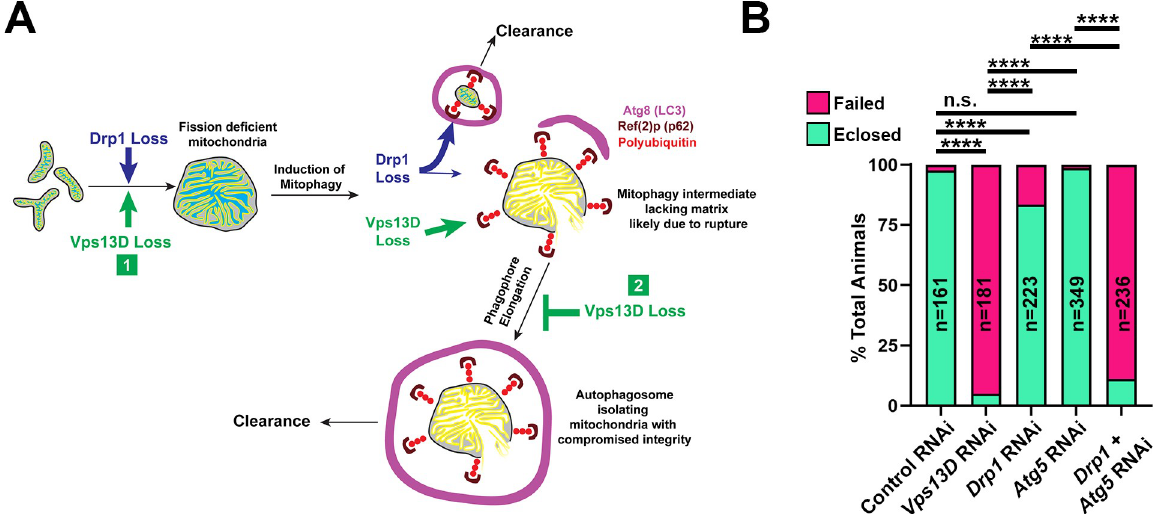
Fig 7. Two-hit model for lethality in Vps13D depleted neurons. A) Two-hit model for mitophagy intermediates lacking matrix (cyan), but containing IMM (yellow) that are present in Vps13D depleted neurons. (1) loss of Vps13D and loss of Drp1 lead to similar defects in mitochondrial fission and an induction of mitophagy. In Drp1 depleted neurons (blue arrows and text), mitophagy clears the majority of smaller, matrix-containing mitochondria, while a subpopulation of larger mitophagy intermediates lacking matrix exist that appear stalled. In Vps13D depleted neurons (green arrows and text), a second role for Vps13D is revealed for (2) elongating the phagophore around damaged mitochondria. Therefore, depletion of Vps13D causes the accumulation of mitophagy intermediates (top right) that are polyubiquitinated, coated with Ref(2)p ( Drosophila homolog of p62), engaged with a stalled phagophore (labeled by Atg8 which is the Drosophila homolog of LC3), and lacking in matrix proteins likely due to rupture. B) Quantification of successful eclosion frequency of pupae with the indicated RNAi driven by pan-neuronal driver nSyb-Gal4. n.s. indicates no significant difference, ��� indicates p < 0.001, and ���� indicates p < 0.0001 based on Chi square test of two compared genotypes